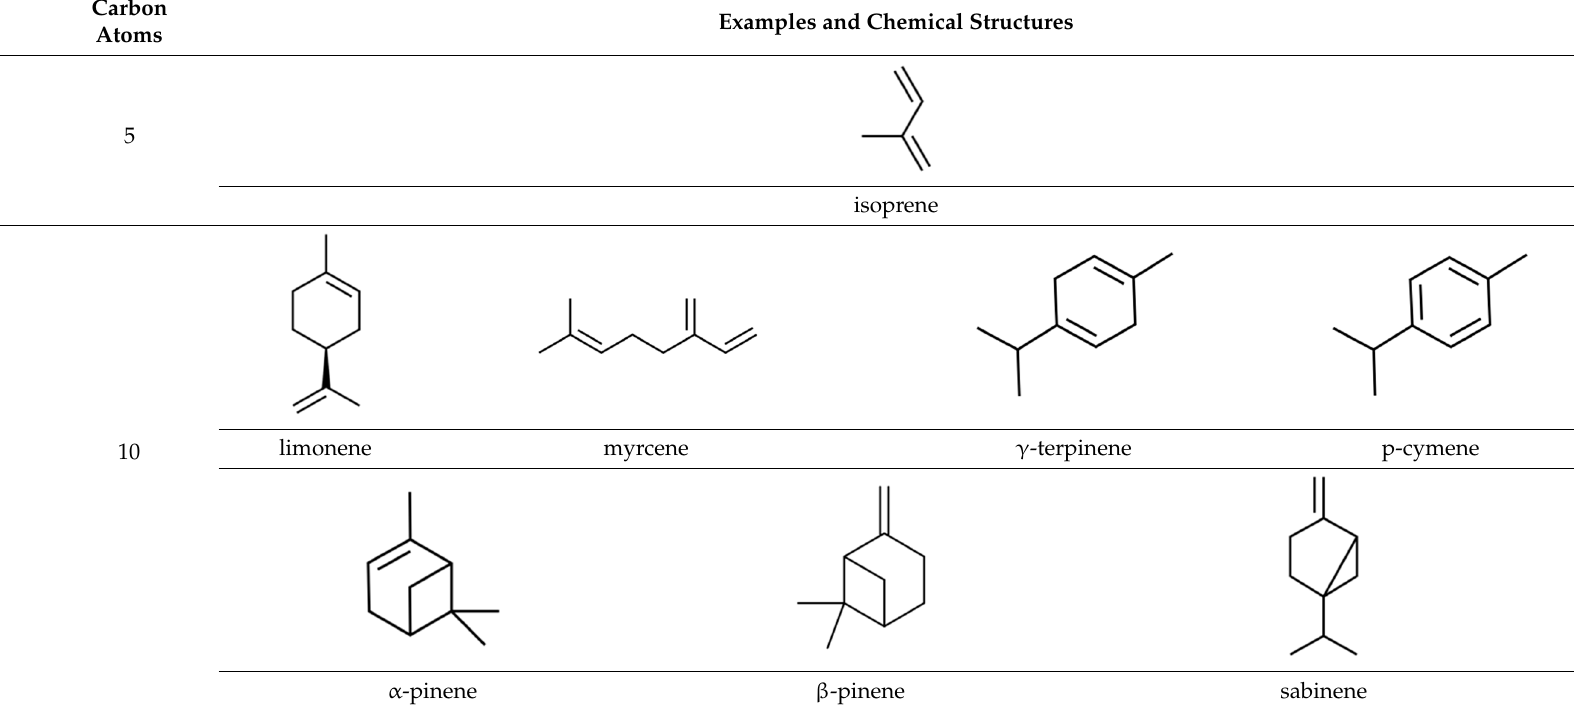
Table 1. Summary of the main hydrocarbon terpenes and the associated number of isoprene units and carbon atoms.